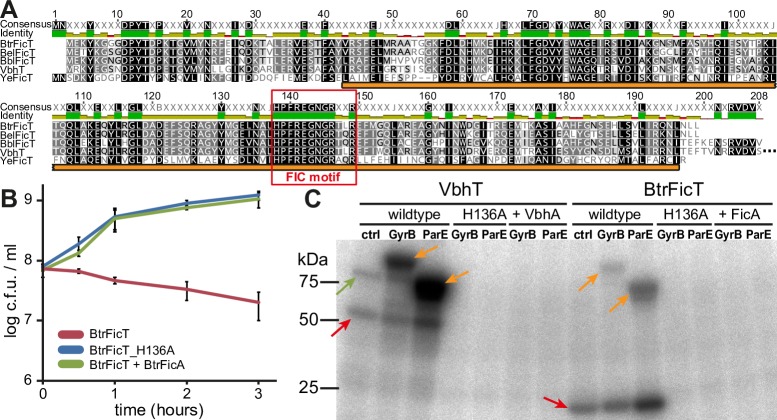
BtrFicTA is a regular FicTA module closely related to VbhTA.(A) Sequence alignment of YeFicT (UniProt identifier A1JNF3 (A1JNF3_YERE8)) and the FIC domain of VbhT (UniProt identifier E6Z0R3 (VBHT_BARSR)) with BtrFicT (UniParc identifier UPI00015FA8A2) and orthologs encoded by Bartonella elizabethae (BelFicT; UniParc identifier UPI00026E5C06) and Bartonella birtlesii (BbiFicT; UniParc identifier UPI00026E6E87). The FIC domain core (interpro IPR003812) is highlighted with an orange bar. BtrFicT and its orthologs have > 70% identical sequence and share 60% sequence identity with the FIC domain of VbhT. The four proteins have 28% identical sequence with YeFicT. Note that all sequences display a canonical HPFX[D/E]GNGRXXR FIC signature motif (red frame), indicating AMPylation as their molecular activity [34]. The coloring indicates amino acid similarity according to the Blosum62 score matrix with black = 100% identity and white = <60% identity. (B) The colony forming units (c.f.u.) / ml of exponentially growing E. coli were recorded over time after the expression of BtrFicT constructs had been induced at t = 0 h with 2 mM of IPTG. Data points represent average and standard deviation of three independent experiments. (C) Autoradiograph of an AMPylation assay with lysates of E. coli that had expressed different VbhT or BtrFicT constructs. Reactions were set up by adding [α-32P]-ATP to trace AMPylation and lysates of E. coli that expressed GST-fusions of E. coli GyrB (DNA gyrase B subunit), E. coli ParE (topo IV B subunit), or a vector control. The autoradiograph shows VbhT and BtrFicT auto-AMPylation (red arrows), AMPylation of endogenous E. coli GyrB by VbhT (green arrow), and the AMPylation of ectopically expressed GST-GyrB and GST-ParE for both constructs (orange arrows). Note that the “BtrFicT” construct included expression of a marginal amount of BtrFicA which we determined to be necessary for the generation of soluble BtrFicT (see S1 Text).